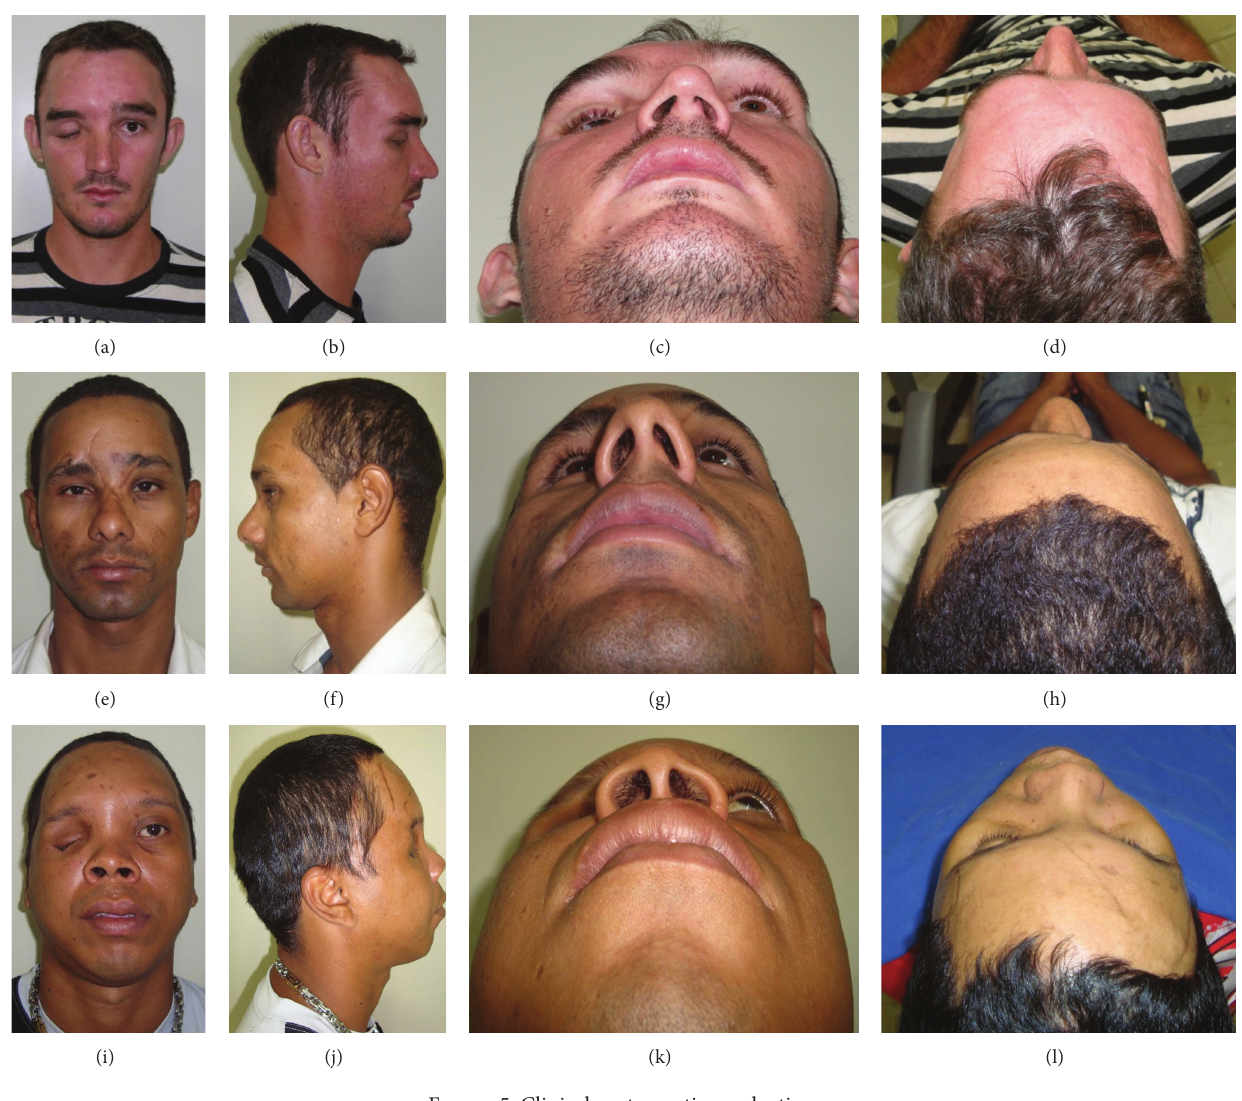
Figure 5: Clinical postoperative